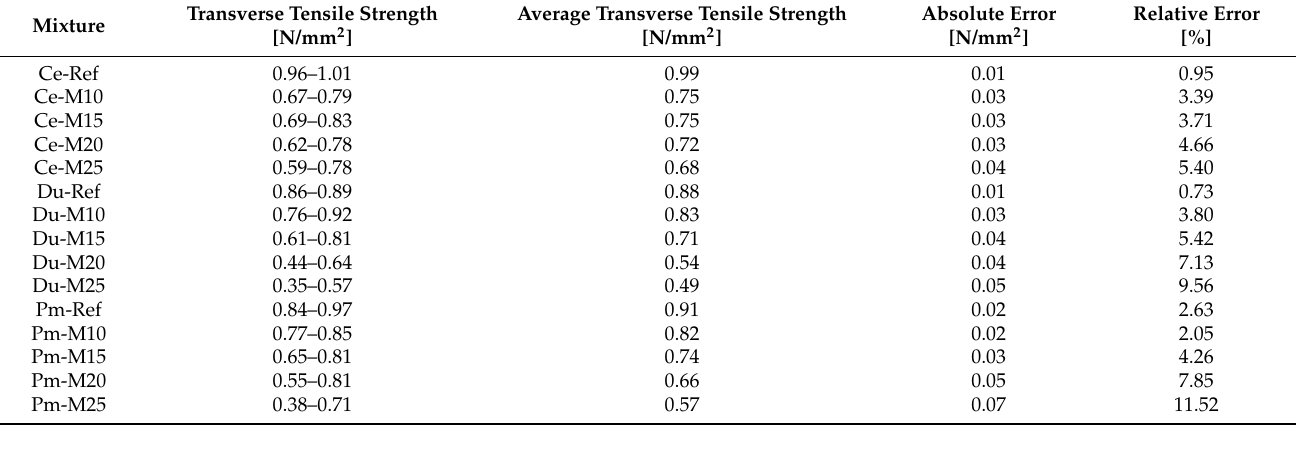
Table 6. Results of transverse tensile strength perpendicular to the plane of the board testing of modified cement-bonded particleboards.